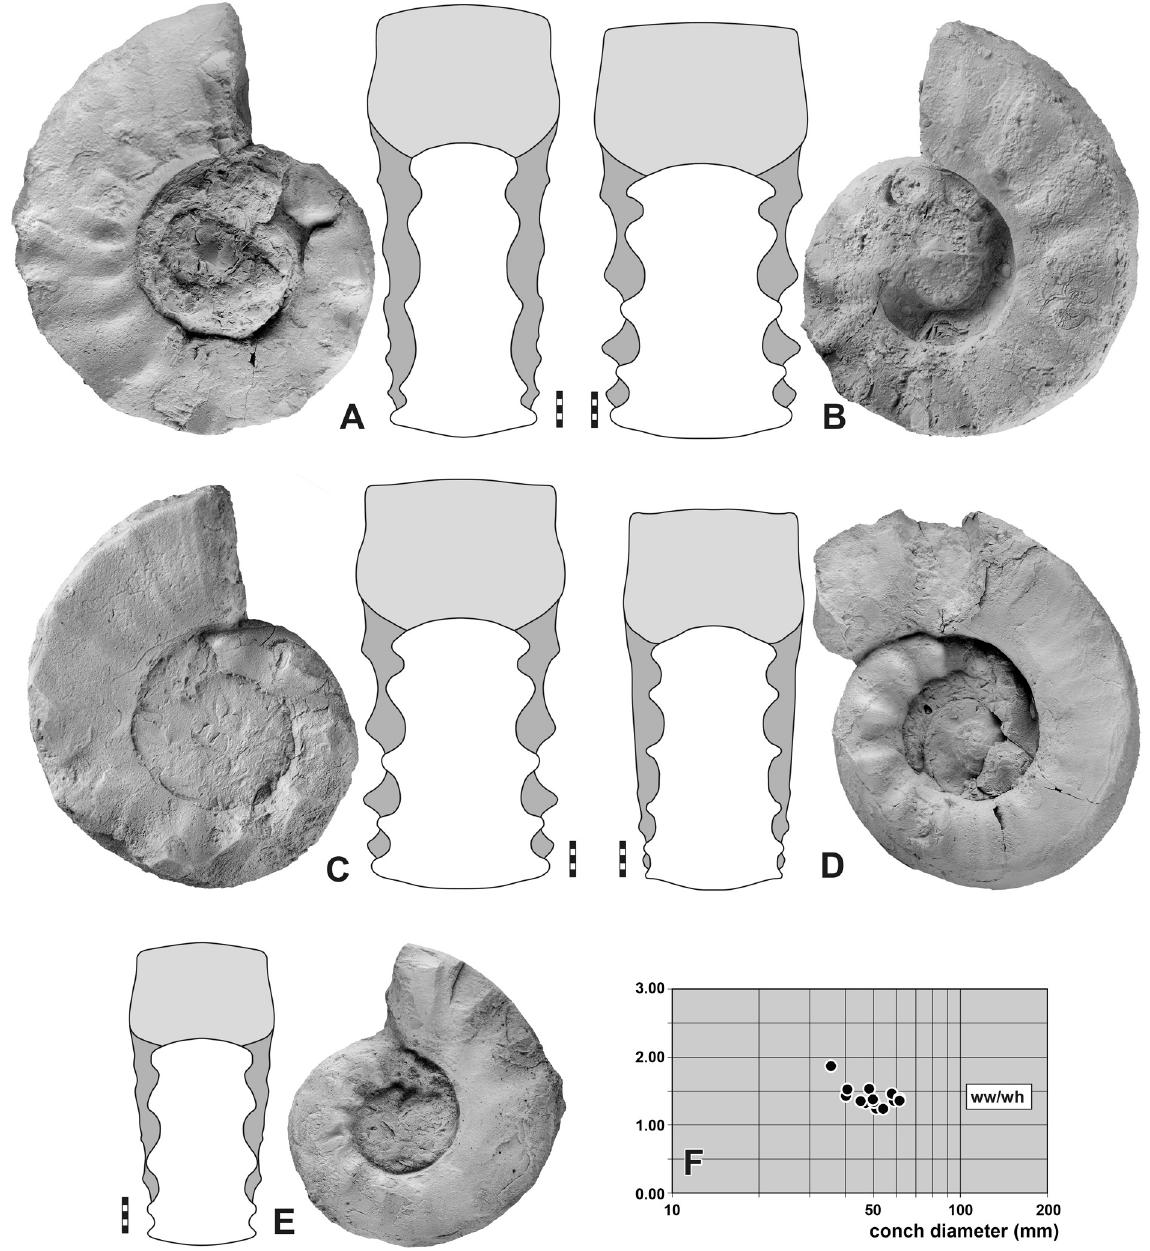
Fig. 48. Alibashites ferdowsii Korn & Ghaderi, 2016. A . Lateral and dorsal view, specimen MB.C.29974, section 1, -1.60 m. B . Lateral and dorsal view, specimen MB.C.29990, section G, float. C . Lateral and dorsal view, specimen MB.C.29987, section E, float. D . Lateral and dorsal view, specimen MB.C.29980, section C, -1.15 m. E . Lateral and dorsal view, specimen MB.C.29979, section B, float. F . Whorl profile proportions. Scale bar units = 1